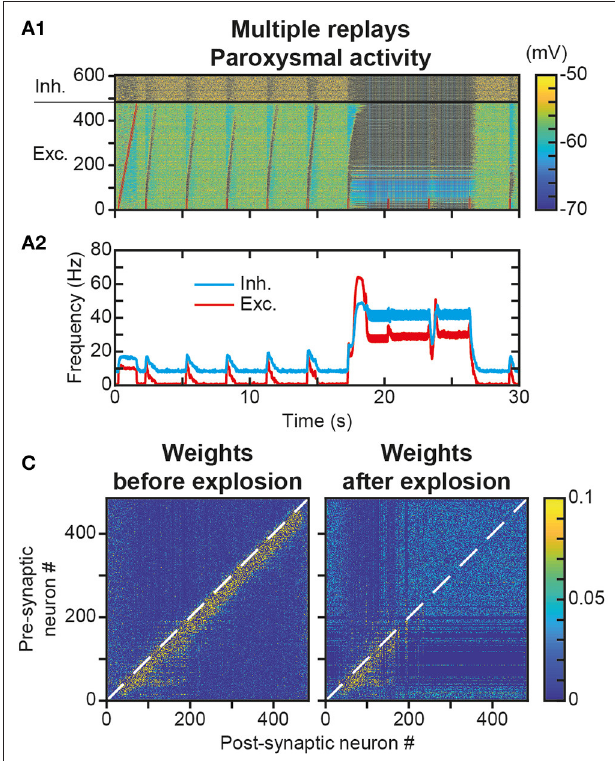
FIGURE 7 | Unstable engram and network dynamics after repeated trajectory replays. (A) . Membrane potential of neurons in the neural network (A1) for 30s during which a replay stimulus is performed on the first 50 neurons every 3s. Mean activity of excitatory (red) and inhibitory (blue) neurons (A2) . (B) . Matrix of synaptic weights between excitatory neurons before (left) and after (right) paroxysmal network activity.